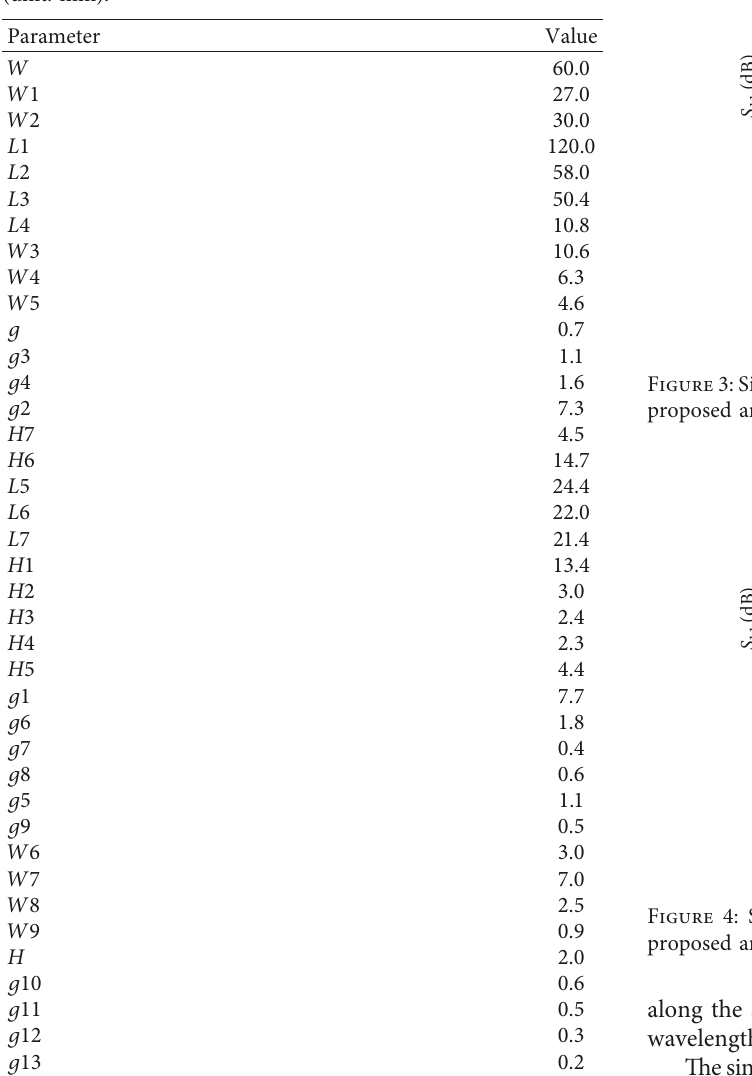
Table 1: Geometric parameters for the proposed antenna (unit: mm).